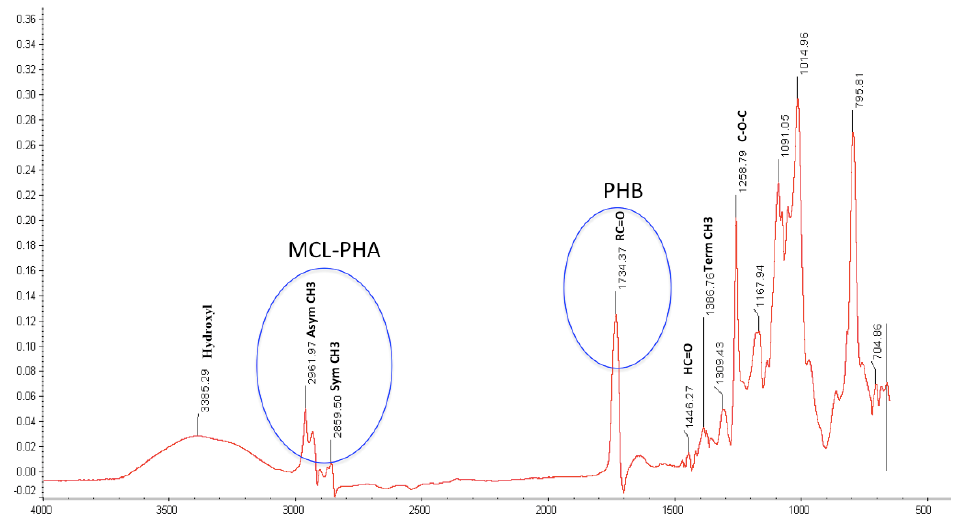
Figure 3. FT ‐ IR spectrum of PHA polymer synthesized by P. putida 46123 grown on octanoic acid.